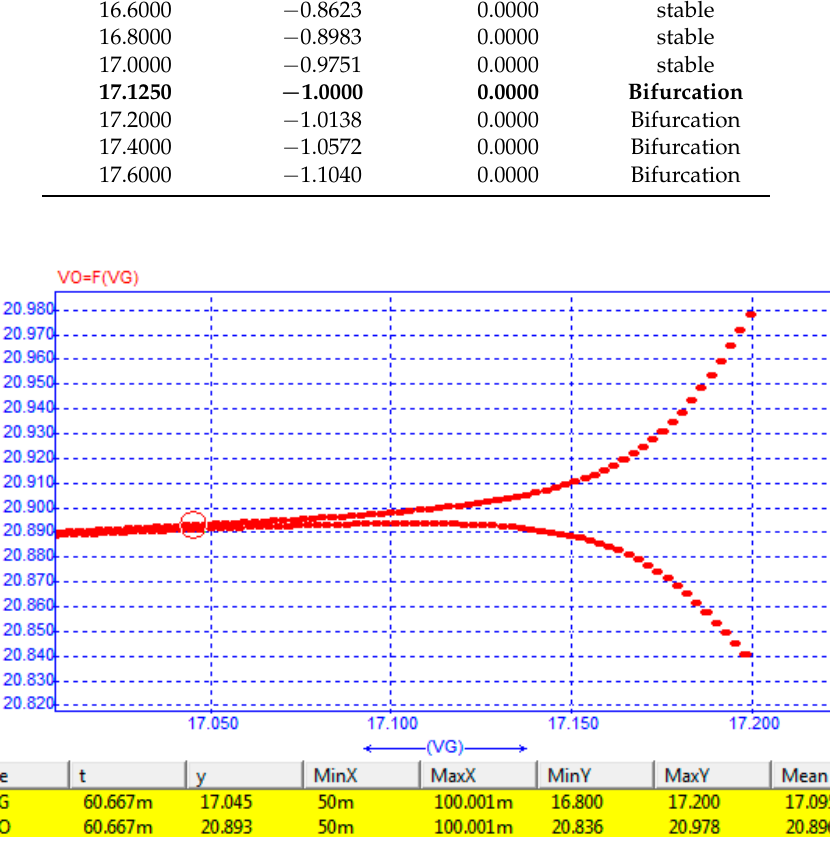
Figure 17. Phase portrait for V g = 16.50 V, confirming stable operation. In Figure 18 the behavior for an input voltage of 17.2 V, higher than the bifurcation threshold is depicted. The bifurcation phenomenon is obvious. Further increase of the input voltage will drive the system into chaos, as Figure 19 presents for an input voltage equal to 17.8 V.